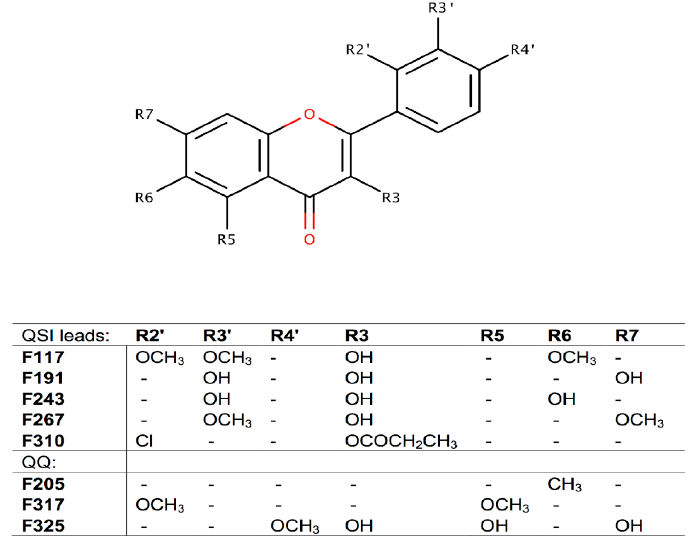
Figure 3. The flavone backbone and the varying substituents of the QS inhibition leads as well as the quorum quenchers. QSI indicates Quorum Sensing Inhibitors; QQ indicates Quorum Quenchers.